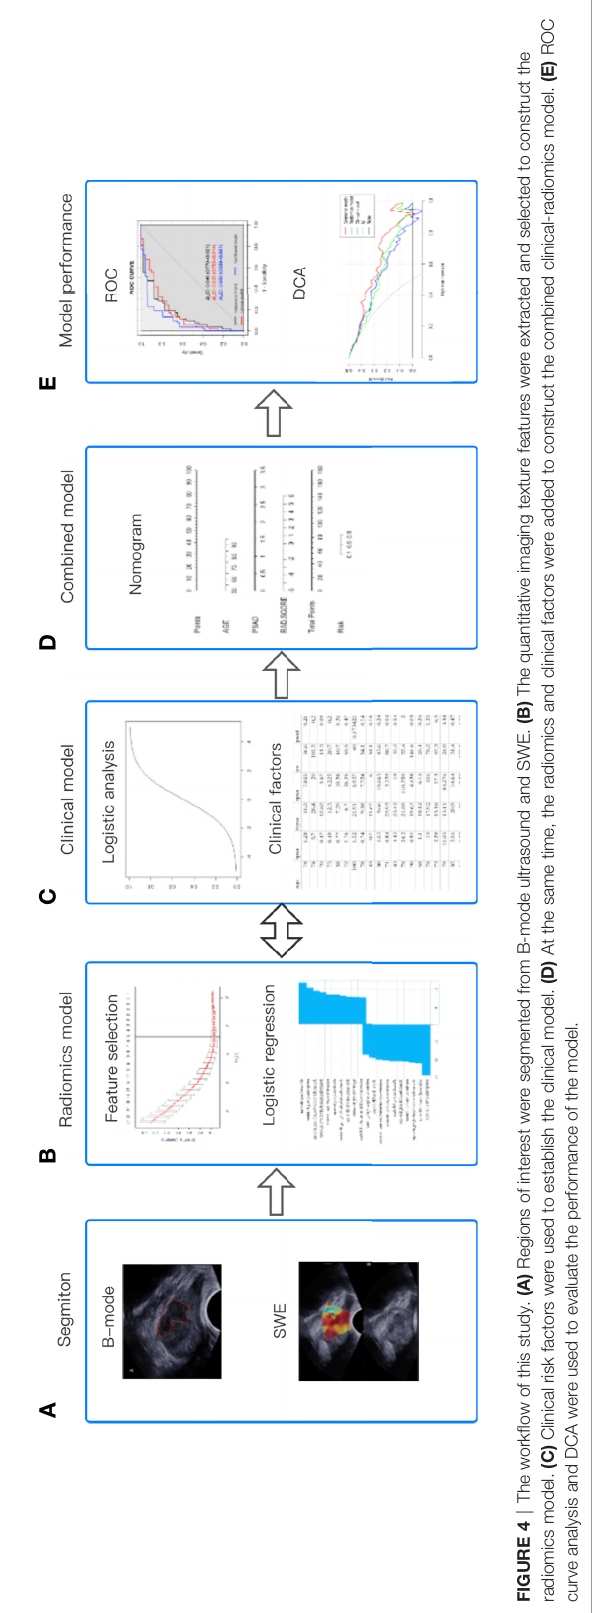
TABLE 1 | Characteristics of all patients (n = 112).